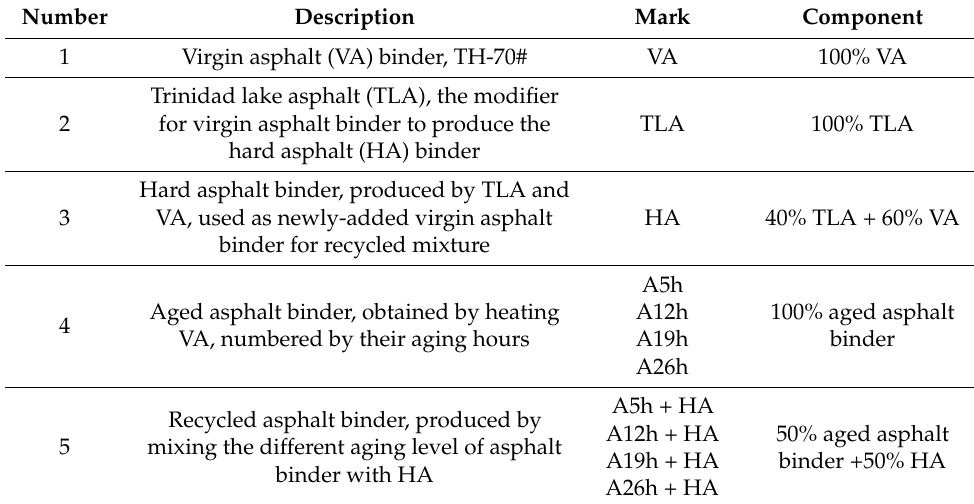
Table 3. Details of the prepared asphalt binder